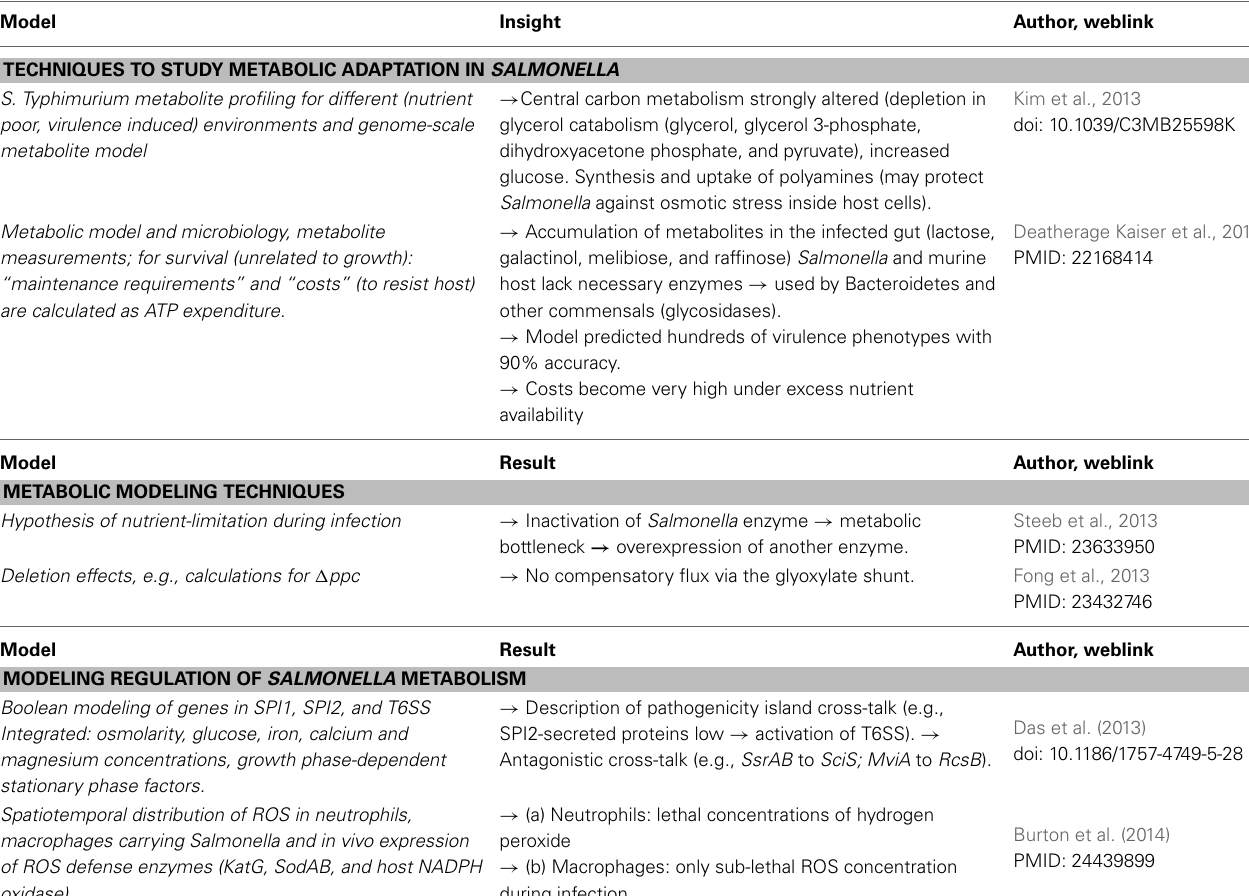
Table 2 | Techniques to model Salmonella metabolism and its